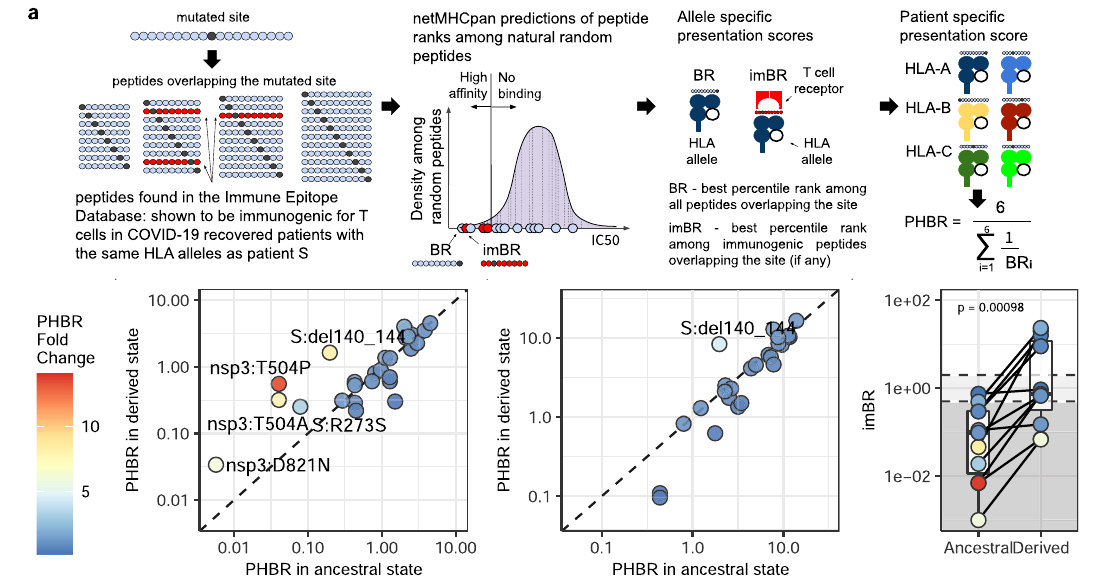
Fig. 2 | Mutational escape from cytotoxic T cells. a Calculation of site pre- sentation scores (adapted from Marty et al. 30 ). b , c Change of PHBR scores caused bymutationsforHLAI b andHLAII c ,respectively.DotcolorcorrespondstoPHBR fold change; the mutations that substantially (>3-fold) increase PHBR are signed. Sitesthatdidnotbindanyofthepatient ’ sHLAallelesbothinancestralandderived states are not shown. d Comparison of imBR scores for the mutated sites in their